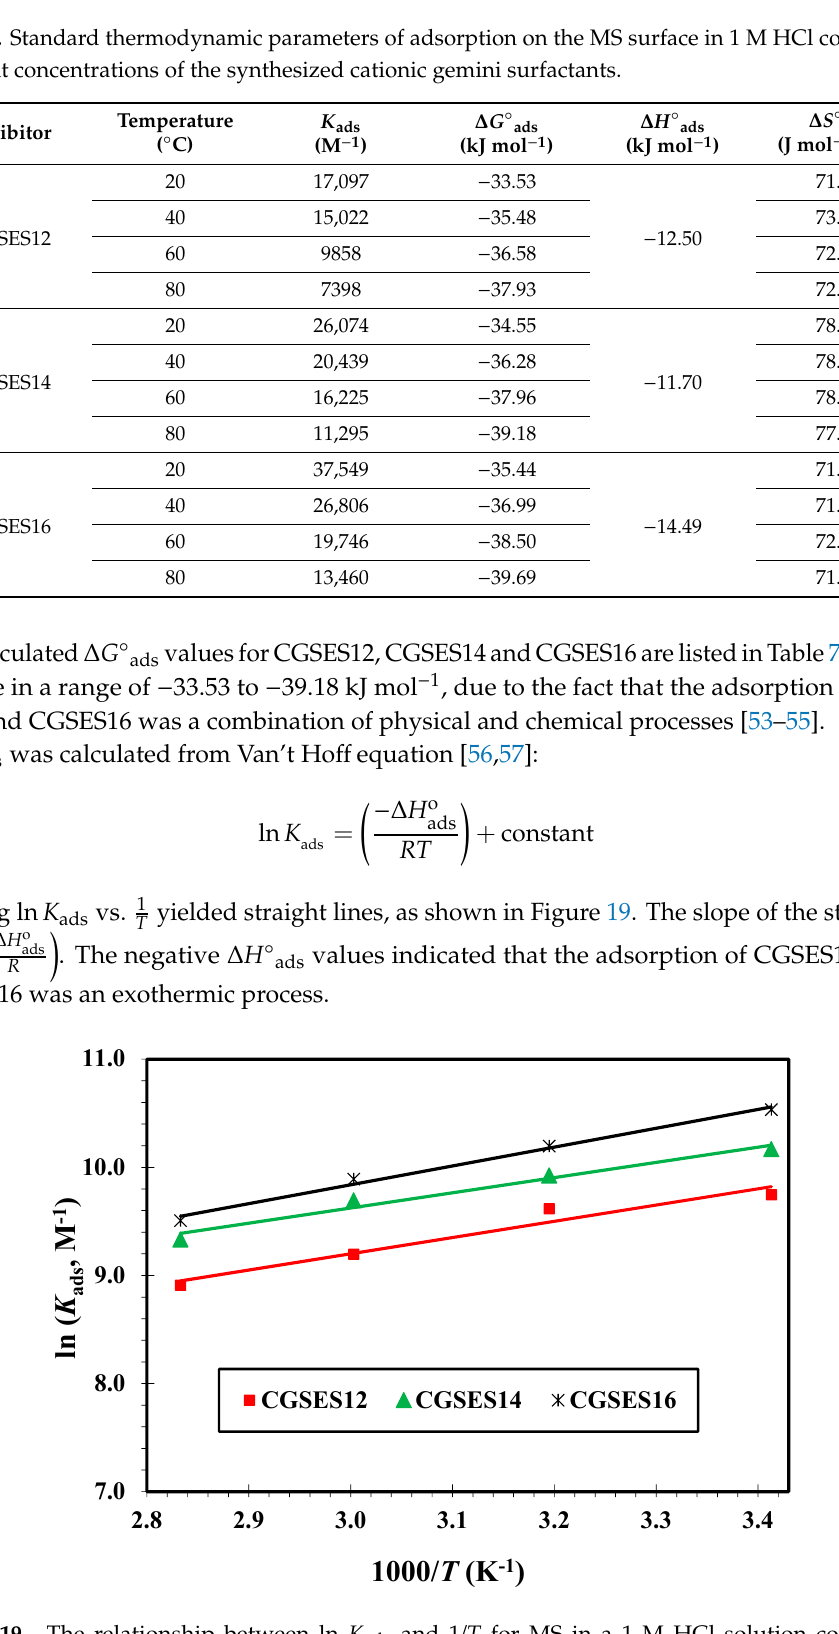
Figure 19. The relationship between ln K ads and 1 / T for MS in a 1 M HCl solution containing different concentrations of the synthesized cationic gemini surfactants on the MS surface in 1 M HCl at different temperatures.